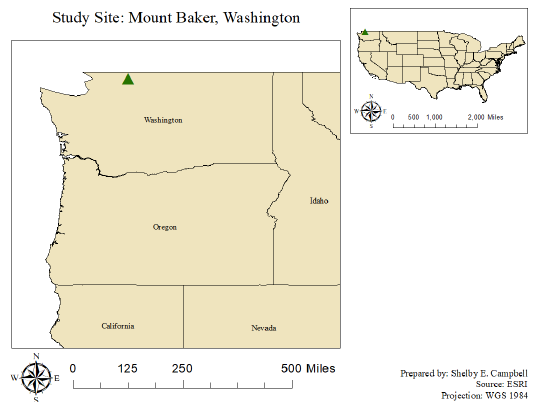
Figure 1: Study Site location of Mount Baker Washington, indicated by the green